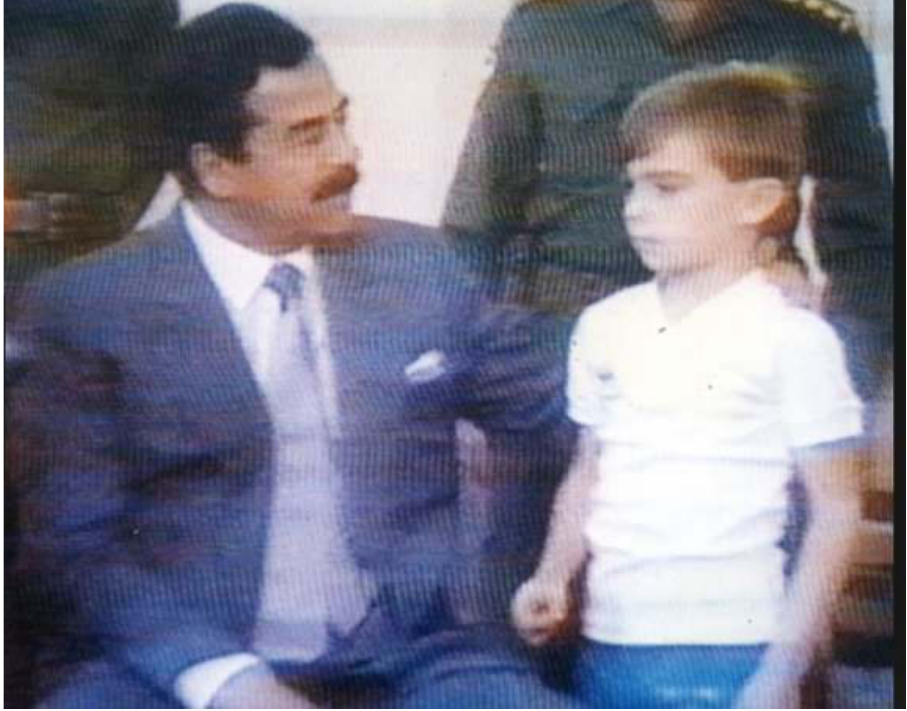
Figure 2. TV footage of Saddam Hussein with a 5-year-old British hostage on 24 August 1990